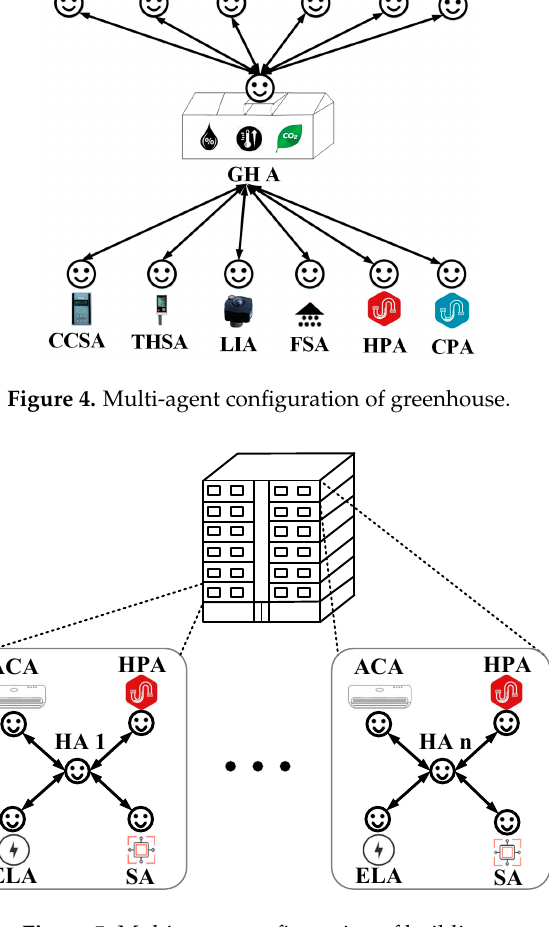
Figure 5. Multi-agent configuration of building.